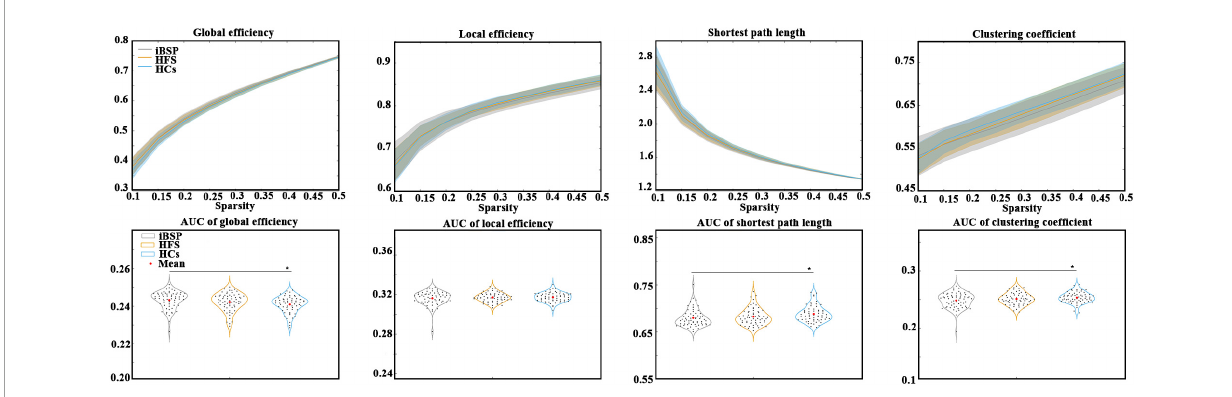
FIGURE2 Comparisons of topological characteristics among groups. The top row shows the topological characteristics across a range of sparsity (0.1–0.5) at an interval of 0.05, and the bottom row shows the area under the curve of each topological characteristic. Group differences in network parameters were explored using analysis of covariance and post-hoc two-sample t -tests between any two groups, with age and gender as covariates. *Represents significant results with P < 0.05. AUC, area under the curve; HCs, healthy controls; HFS, hemifacial spasm; iBSP, idiopathic